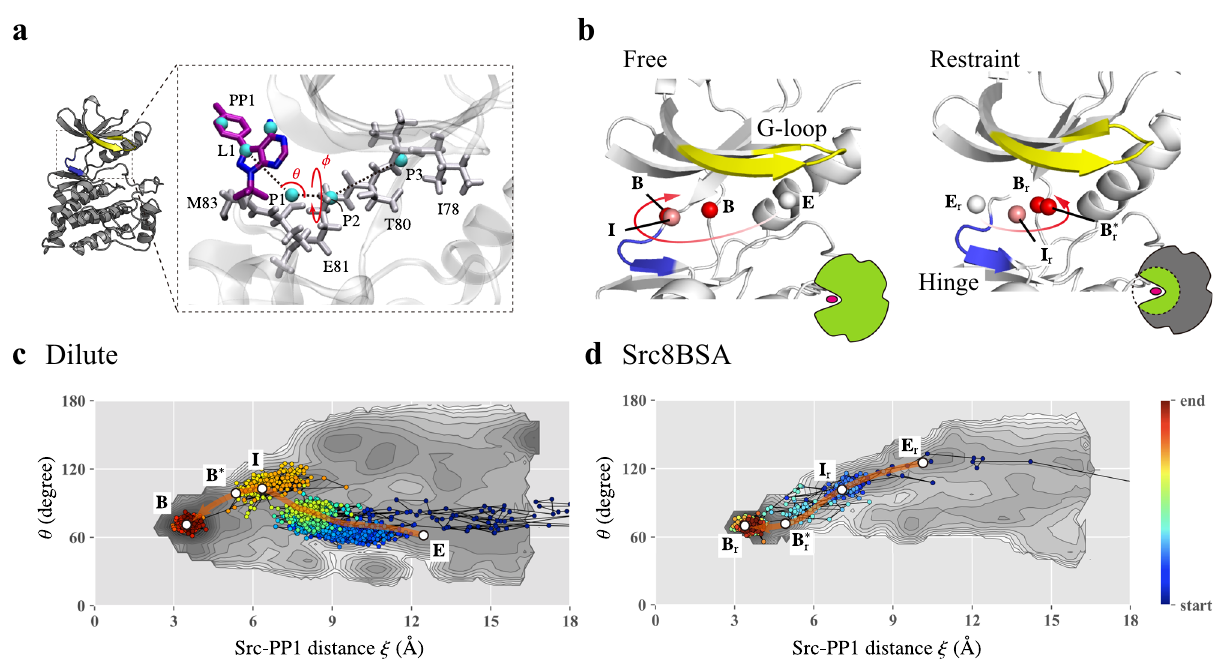
Fig. 4 Binding trajectories projected onto the two-dimensional free energy landscapes (FELs) obtained from the gREST/REUS simulations in the dilute solution. a De fi nition of azimuth angles ( θ , φ ) for describing the relative position (See Supporting information for the detail). b The major binding pathway in the dilute solution obtained from the gREST/REUS simulation in different conditions. Left panel: simulation without any restraints (free), Right panel: simulation in which the residues outside the binding pocket are kept close to the crystal structure. E , I , B * , and B , respectively, indicate encounter complex, intermediate, pre-bound, and bound states. The subscript r denotes the presence of the restraints. c , d The binding trajectories in the dilute solution and in the crowded solution (Src8BSA) projected onto the 2D-FEL from “ free ” simulation and that from “ restraint ” simulation,